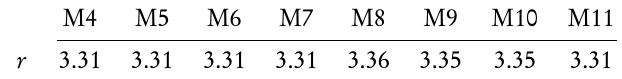
Estimated thresholds from models M4 – M11 of Table 2 on the Canadian lynx